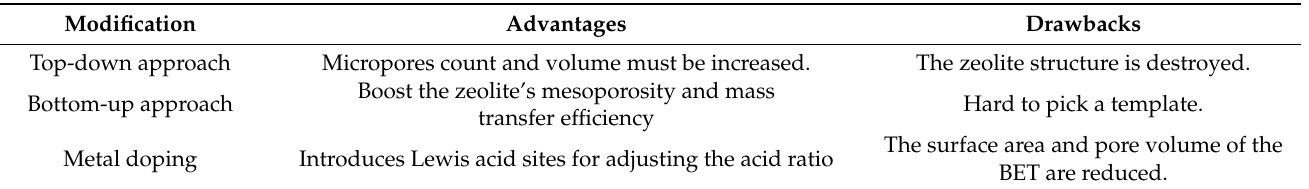
Table 1. Effects of modified zeolites